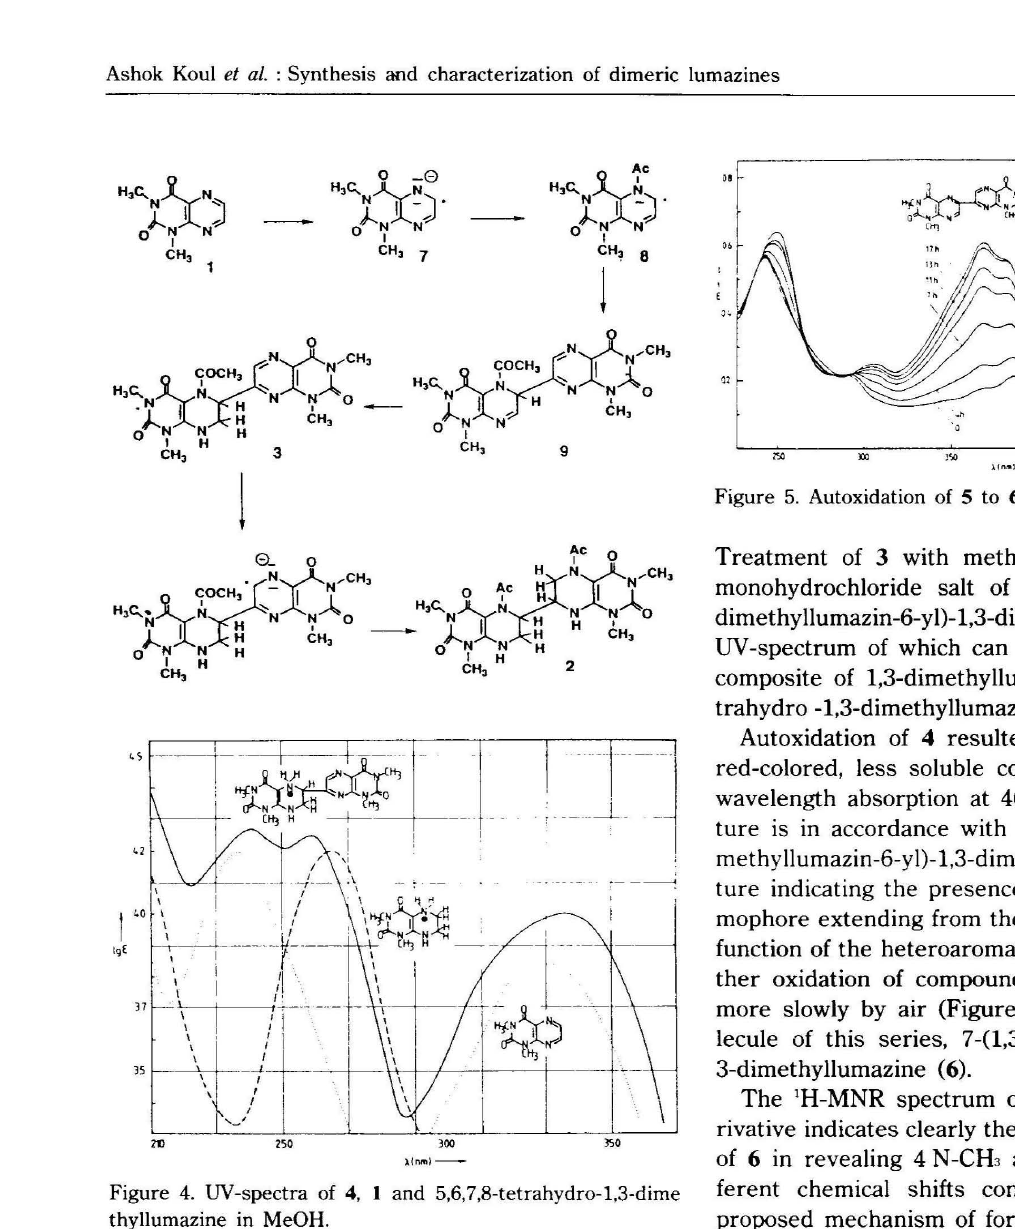
Figure 4. UV-spectra of 4, and 5,6,7,8-tetrahydro-1,3-dime thyllumazine in MeOH.